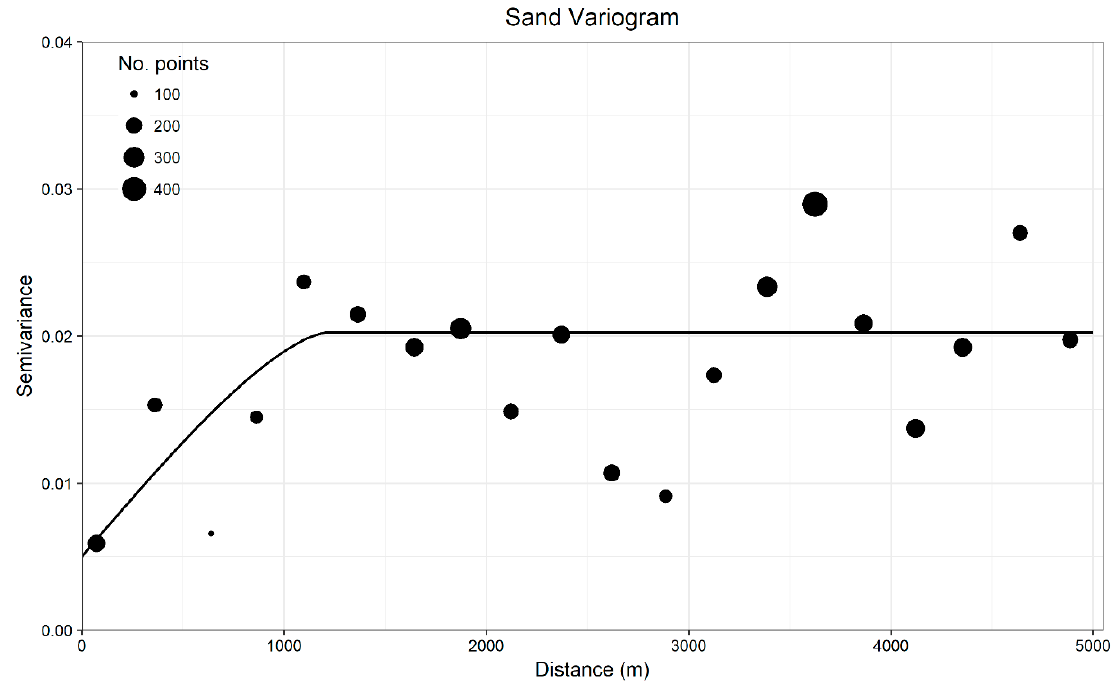
Figure A2. Sand fraction variogram circular model with 250 m lags; nugget = 0.0050, partial sill = 0.0152, major range = 1210.05 m.